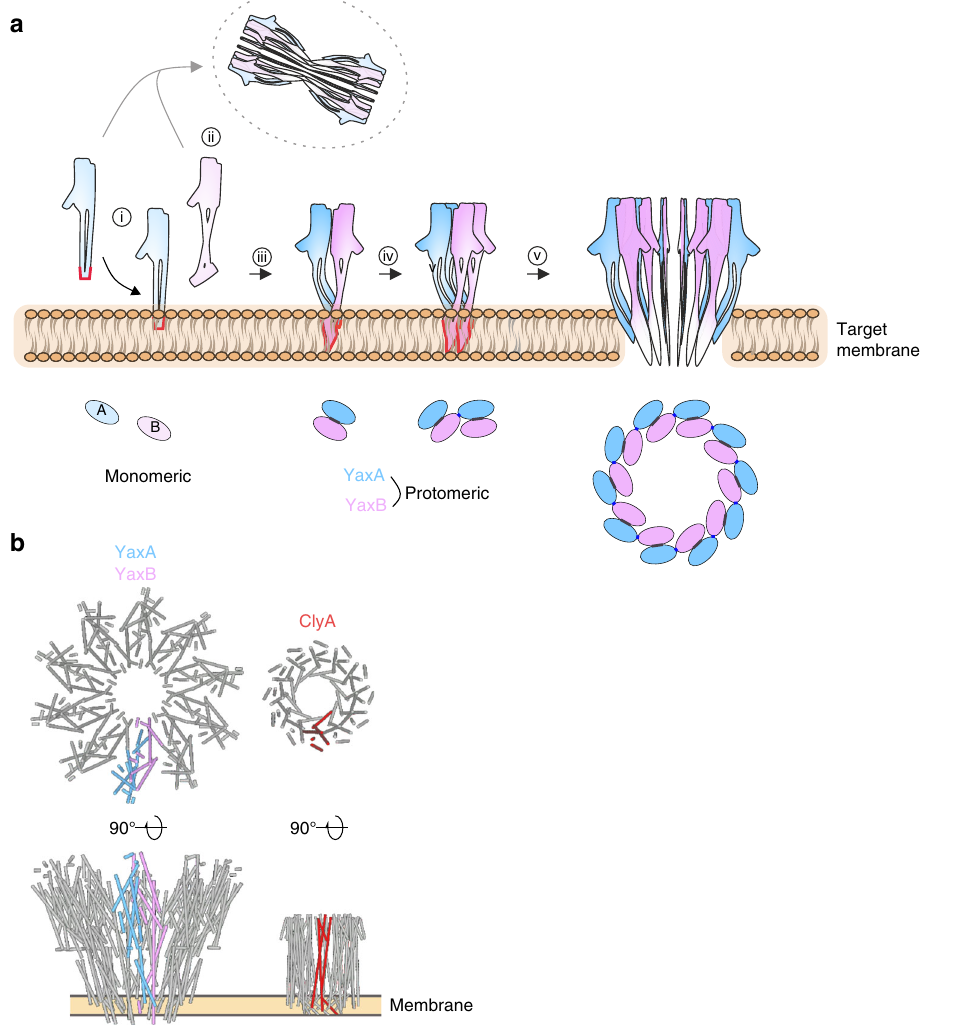
Fig. 7 Assembly of the YaxAB pore and comparison with ClyA. a Schematic overview of our proposed YaxAB pore assembly pathway at targeted membranes. i) YaxA binds to membranes via its hydrophobic foot, ii) after which YaxB, harboring no membrane binding capacity on its own, is recruited. iii) At this stage, YaxB ’ s foot domain rearranges to its membrane-inserted state, stabilized by YaxA ’ s hydrophobic foot. iv) Another membrane-bound YaxAB dimer interacts with the fi rst dimer via the trans YaxA – YaxB contact sites. v) Further association of protomers eventually drive formation of the YaxAB pore. The possibility of off-pathway oligomerization, by subunit interaction prior to membrane binding, is indicated by the gray arrow. Red outlines indicate the exposure of membrane-active moieties. b Comparison of YaxAB (PDB accession code 6EL1) and ClyA (PDB accession code 2WCD 12 ) pore architectures. For a to-scale comparison with the ClyA complex, the structures were tiled in UCSF Chimera. The golden bar indicates approximate membrane and foot domains. For validation, the fi nal 3D map was projected in 2D for exposure, 13 frames were recorded with a total dose of ~60e − / Å 2 and a total comparison with the experimental 2D class averages using EMAN2 57 , imposing exposure time of 1s. 4859 images were automatically acquired using EPU software (FEI), with a defocus of − 2µm. Details of data collection, model re fi nement, and C10 symmetry and using 5° rotational steps. FSC between the model and the fi nal validation are listed in Table 2. map was computed using an online tool based on EMAN2 (https://www.ebi.ac.uk/ Cryo-EM image processing . The image processing work fl ow was performed with RELION 2.1 56 . Image stacks were motion corrected with the program MotionCor2, after which the contrast transfer function values were estimated and corrected using Kai Zhang ’ s Gctf. 1009 particles were manually picked to create templates for autopicking. 178,149 particles were automatically selected and sorted through four runs of 2D classi fi cation. 113,613 particles were chosen for a run of unsupervised 3D classi fi cation, using our negative-stain reconstruction as initial reference. Only the class composed of 10 radial spokes was considered (24,822 particles) and further re fi ned imposing C10 symmetry. After movie re fi nement and particle polishing, the particles were once again re fi ned. Since the reconstructed map had the wrong handedness, apparent by the unusual left-handed coil – coil density, the re fi ned map was fl ipped and fi nally post processed. The fi nal reconstruction used for model building had a resolution of 6.1Å according to the FSC = 0.143 criterion. Local resolution varied from ~5 Å in the head domains to 6 – 7 Å in the coiled-coil